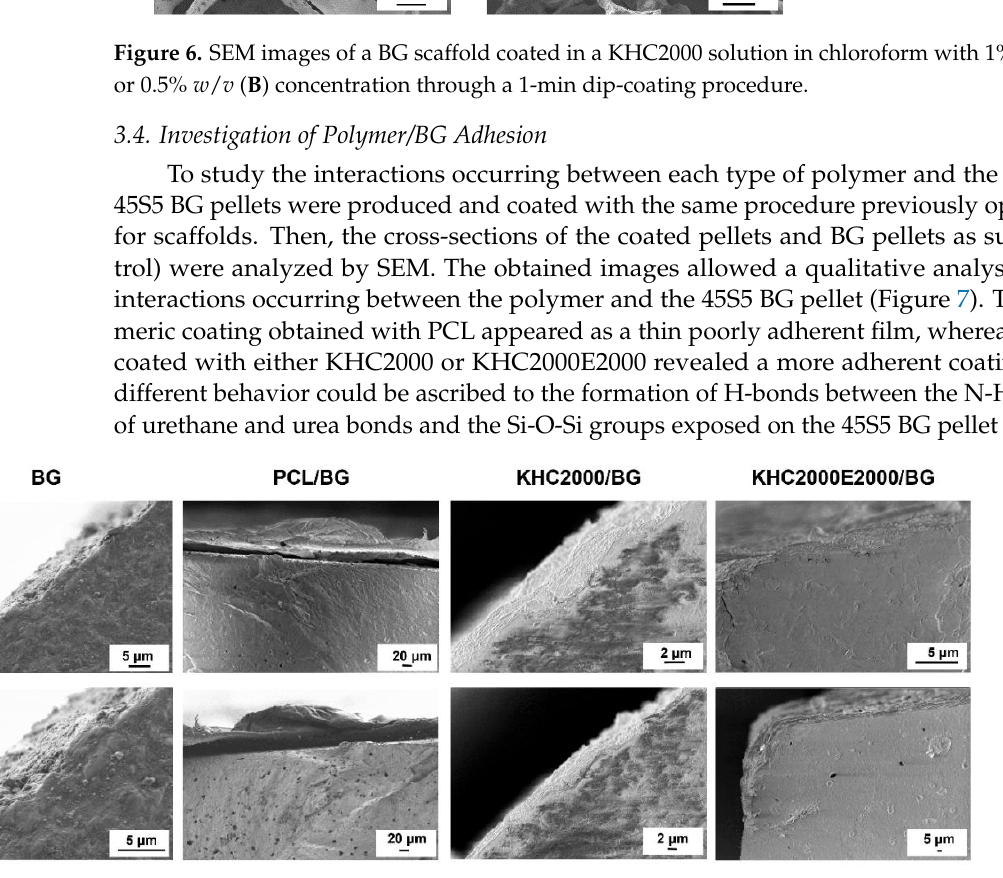
Figure 6. SEM images of a BG scaffold coated in a KHC2000 solution in chloroform with 1% w / v ( A ) or 0.5% w / v ( B ) concentration through a 1-min dip-coating procedure.